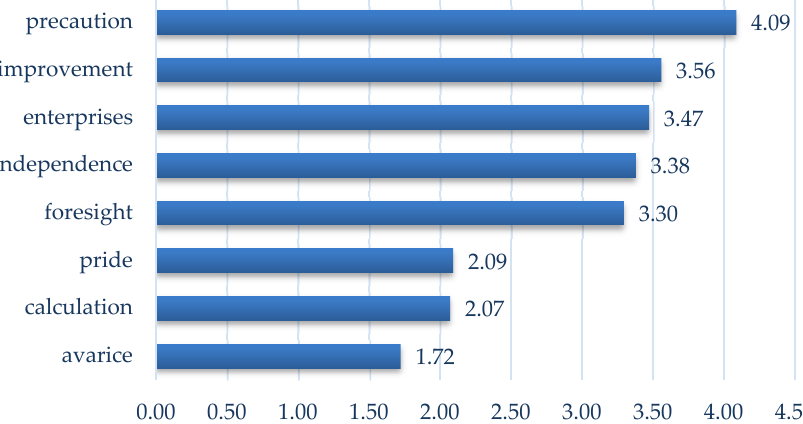
Figure 4. Motives for saving money by the surveyed agricultural households ( n = 191) . Note: assess- ment using a five-point Likert scale; 1—unimportant motive, 5—most important motive. Source: own